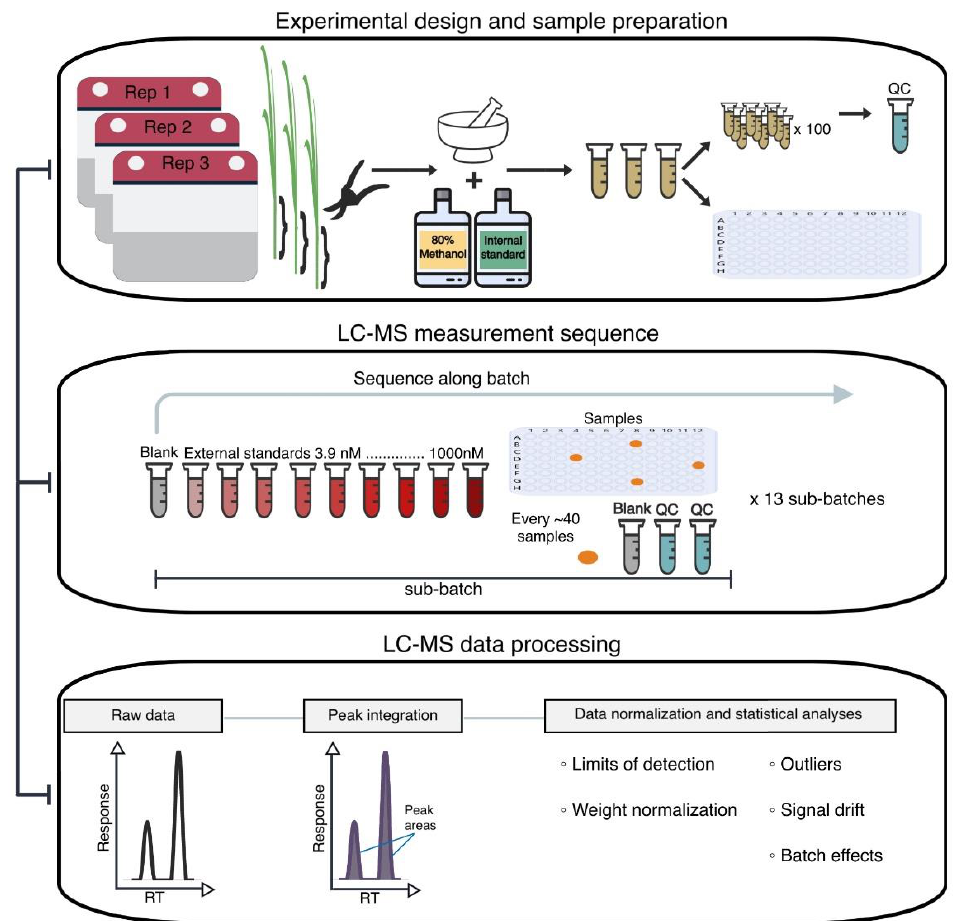
Figure 6. Experimental design, data acquisition, and data processing steps. Samples labeled as QC represent a pooled mixture from 100 randomly selected experimental samples. A representation of the LC–MS measurement sequence for each batch and sub-batch during the data acquisition phase is shown. During data processing, the depiction represents the instrument response as a function of the retention time (RT).